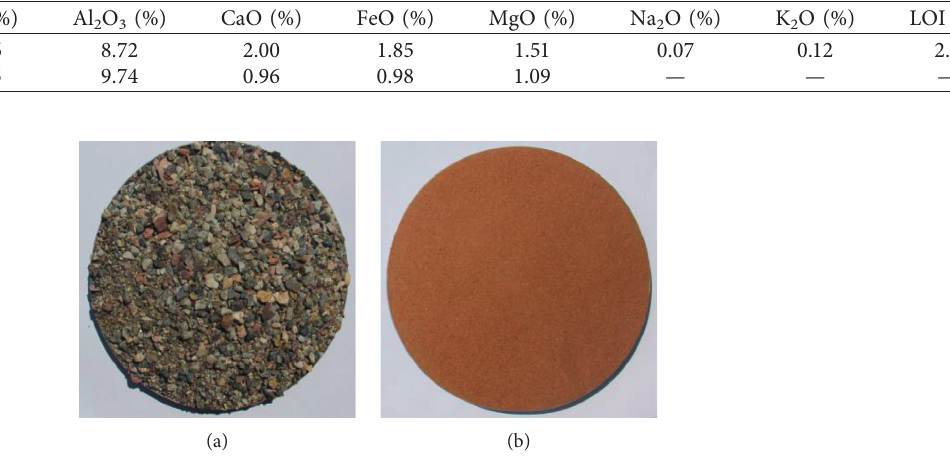
Table 3: Fine aggregate chemical composition.